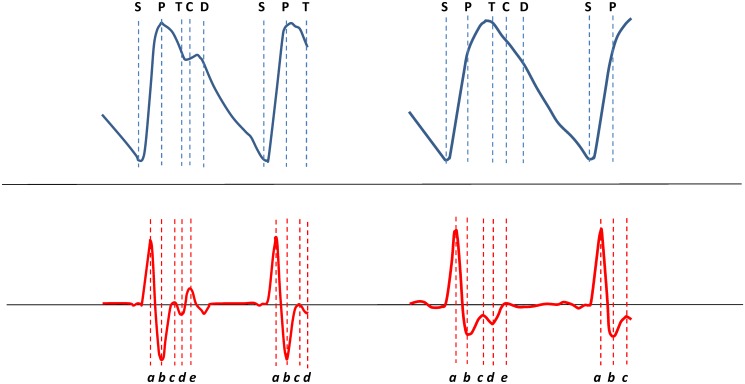
Digital photoplethysmograms and acceleration photoplethysmograms.Authentic digital photoplethysmograms (upper panels) of a 33-year old healthy woman (left panel, heart rate 65 bpm, aging index -0.87) and a 66-year old healthy man (right panel, heart rate 61, aging index -0.09). S = starting point of systole; P = peak of percussion wave; T = tidal wave; C = incisura wave; D = dicrotic wave. Note the absence of a distinct incisura and dicrotic notch in the right plethysmogram, and differences in negative amplitudes of b and d peaks in the acceleration plethysmograms (lower panels).